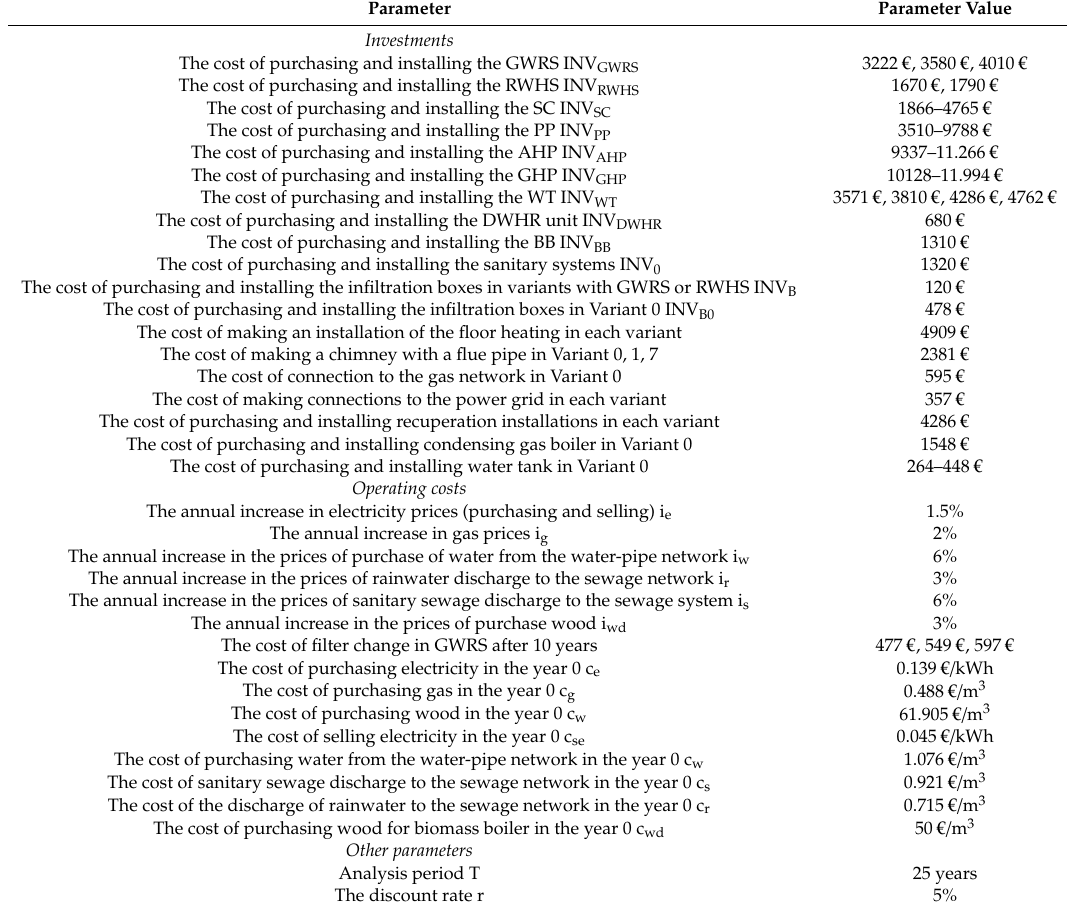
Table 3. Data used in the calculation of LCC